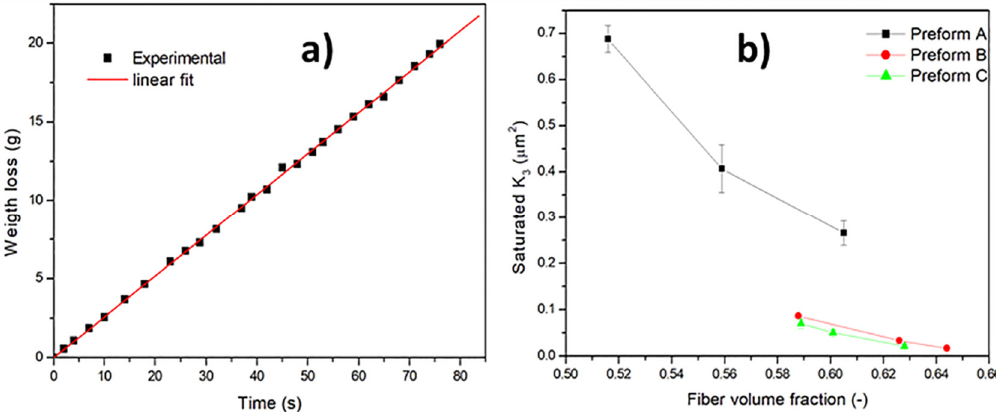
Figure 4. ( a ) Weight loss as a function of time for preform A; ( b ) saturated out-of-plane permeability as a function of fiber volume fraction.